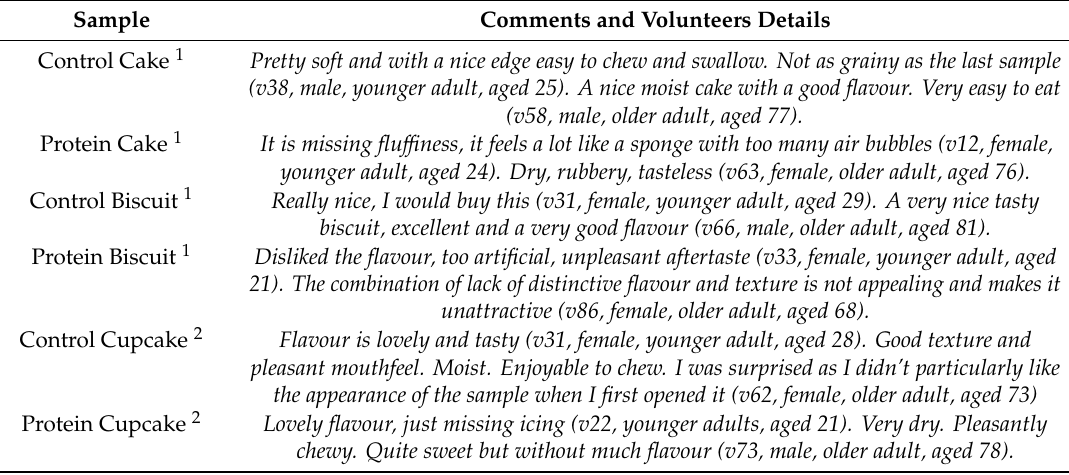
Table 8. Examples of volunteer comments in both